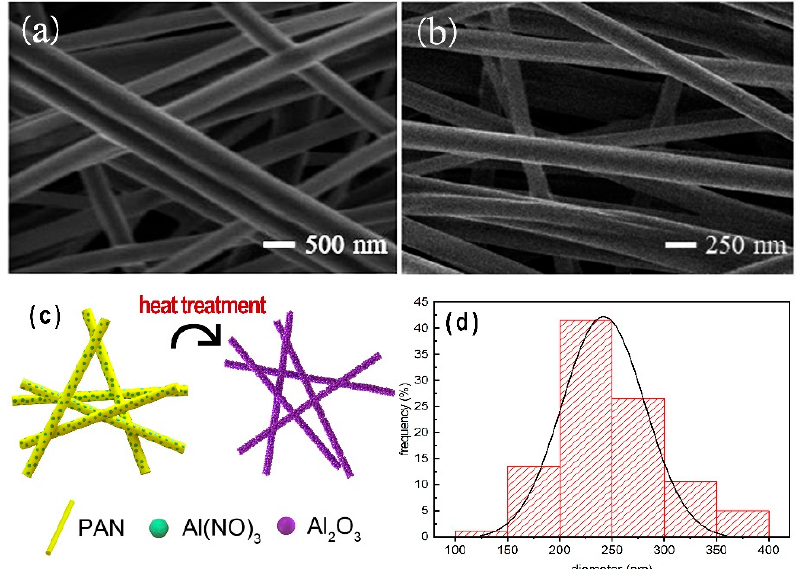
Figure 2. SEM images of the Al 2 O 3 coatings made by electrospinning technique before ( a ) and after heat treatment ( b ). Sketch illustrating the formation mechanism of the Al 2 O 3 nanofiber coatings ( c ). The diameter distribution of Al 2 O 3 nanofibers ( d ).